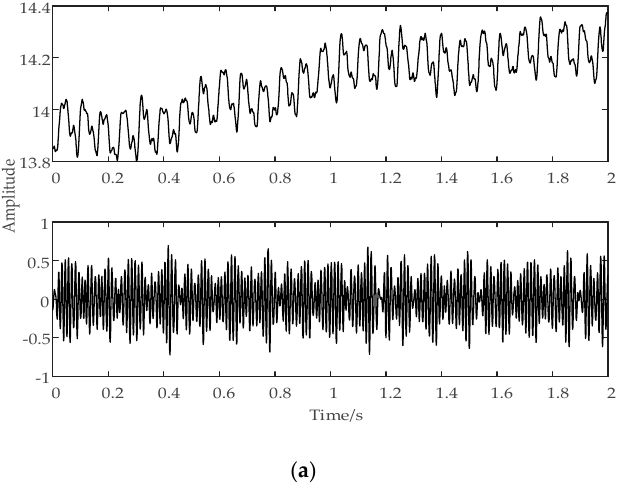
Table 1. The central frequency corresponding to different K